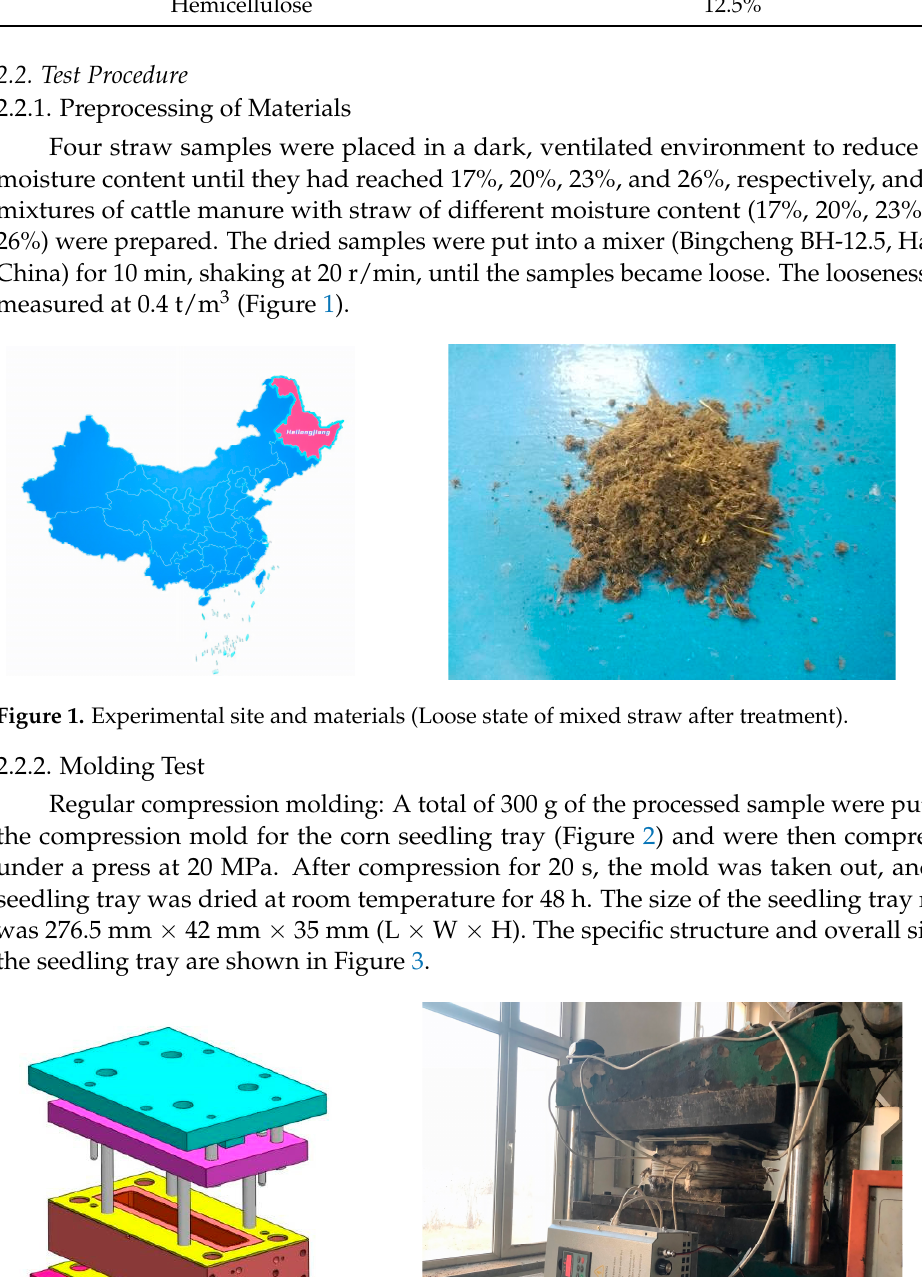
Figure 3. Specific structure and overall size of seedling trays. Hot compression molding: The induction coils of an electromagnetic induction heater were wrapped on the outer surface of the mold material frame, the current of the electromagnetic induction heater was adjusted, and the mold was heated to and kept at 230 °C. A total of 300 g of the processed material (with the same moisture content as used in the regular compression molding) were put into the corn seedling tray compression mold, and then compressed under a press at 20 kN. After compressing at a constant tem- perature for 20 s and then naturally cooling to <50 °C, the mold was taken out. 2.2.3. Seedling Raising Test Seedling raising test: At 2–3 days before sowing, the corn seeds (Demeiya 3) were soaked in warm water at 28–30 °C for 8–12 h, then taken out for drying. The seeds were kept at 20–25 °C to accelerate germination. During this process, seeds were turned over every 2–3 h until radicles appeared. Two centimeters of soil was placed in the holes of the molded regularly and hot-compressed seedling trays, a germinated seed was placed in each hole, a layer of topsoil was added to the edge of the tray, and the seedling tray was watered until the soil was completely soaked. The temperature, humidity, and raising time were set as 25 ± 2 °C, 45–65%, and 15 days, respectively. 2.2.4. Breaking Strength Measurement The crushing strength of the shaped seedling trays with different water content and different treatment methods was measured. The test was repeated three times for each type of seedling tray, and the average value of the three damage results was taken. The molded regularly and hot-compression seedling trays were placed on the test platform of an electronic universal testing machine that followed the GB/T 16491–2008 standard. Un- der unconstrained support, through three-point bending (Figure 4), the seedling tray was damaged at a constant loading rate of 10 mm/min. The stop was set as 6 mm at the closed- loop control, and the duration was set to 10 s.